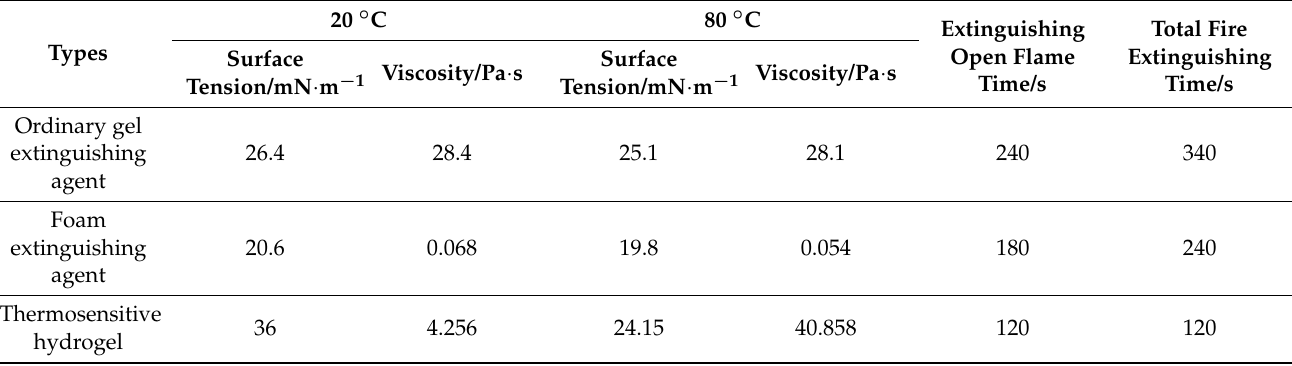
Table 2. Performance parameters and fire extinguishing time of three